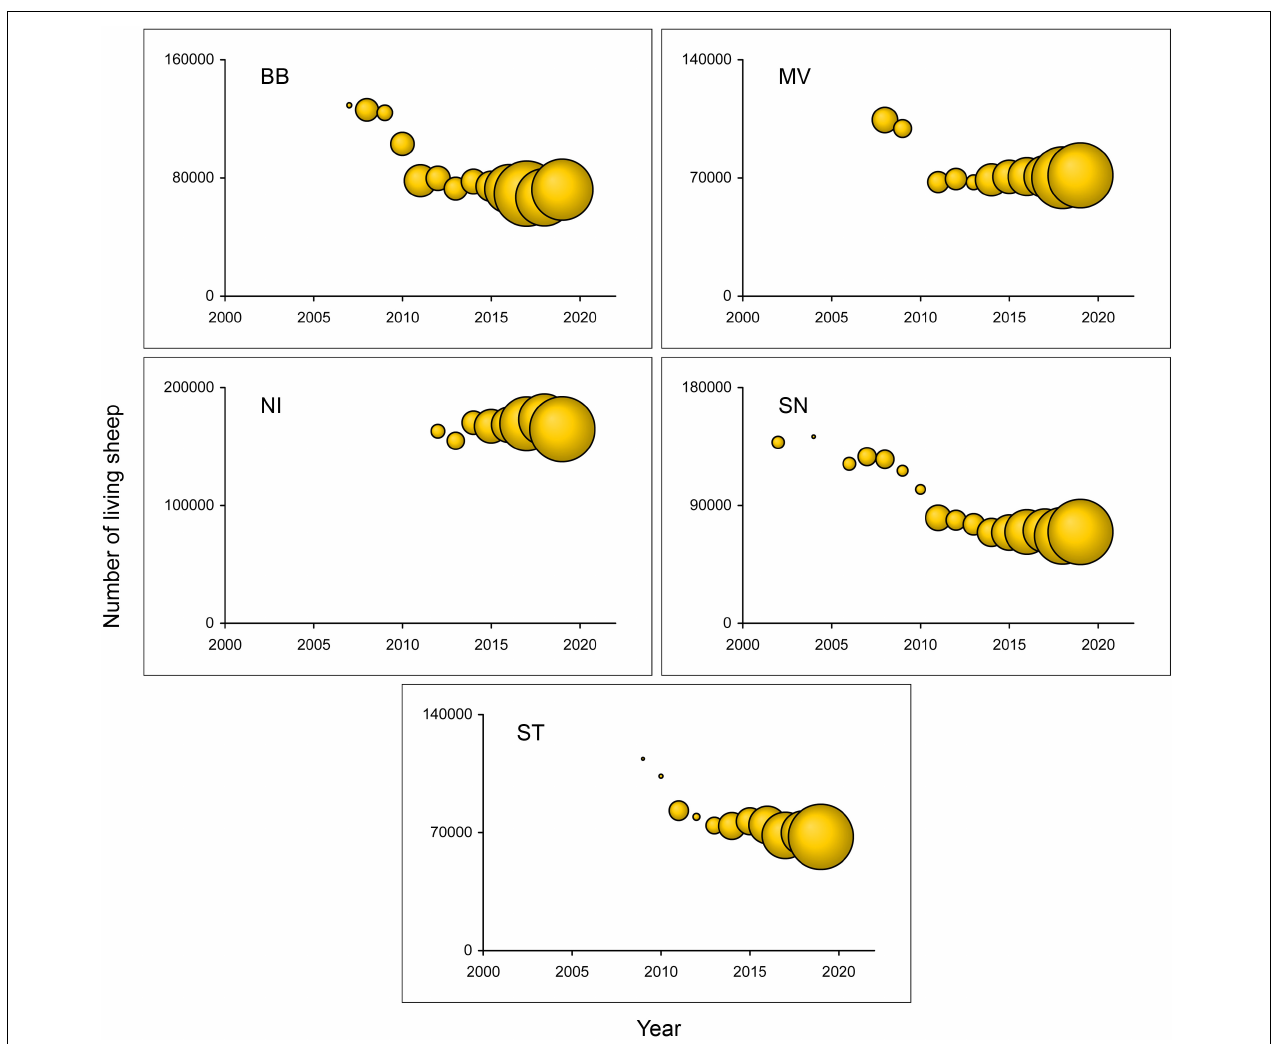
FIGURE 2 | An increase of the percentage of killed/living sheep (bubble diameter) in relation to changes in the numbers of living sheep in German states over years. The graphs include only the states with > 5 annual data. States: BB, Brandenburg; MV, Mecklenburg–Vorpommern; NI, Niedersachsen; SN, Sachsen; ST,